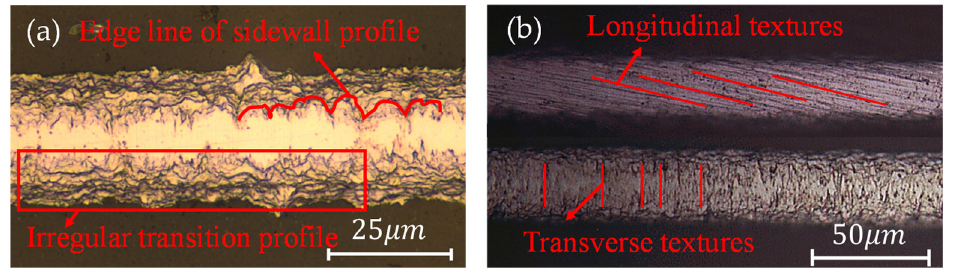
Figure 1. Upper surface roughness and side-wall profile of sensitive grids. ( a ) optical image of sensitive grids and one magnified strip showing the rough side-wall profile; ( b ) upper surface of sensitive grids observed in a microscope.